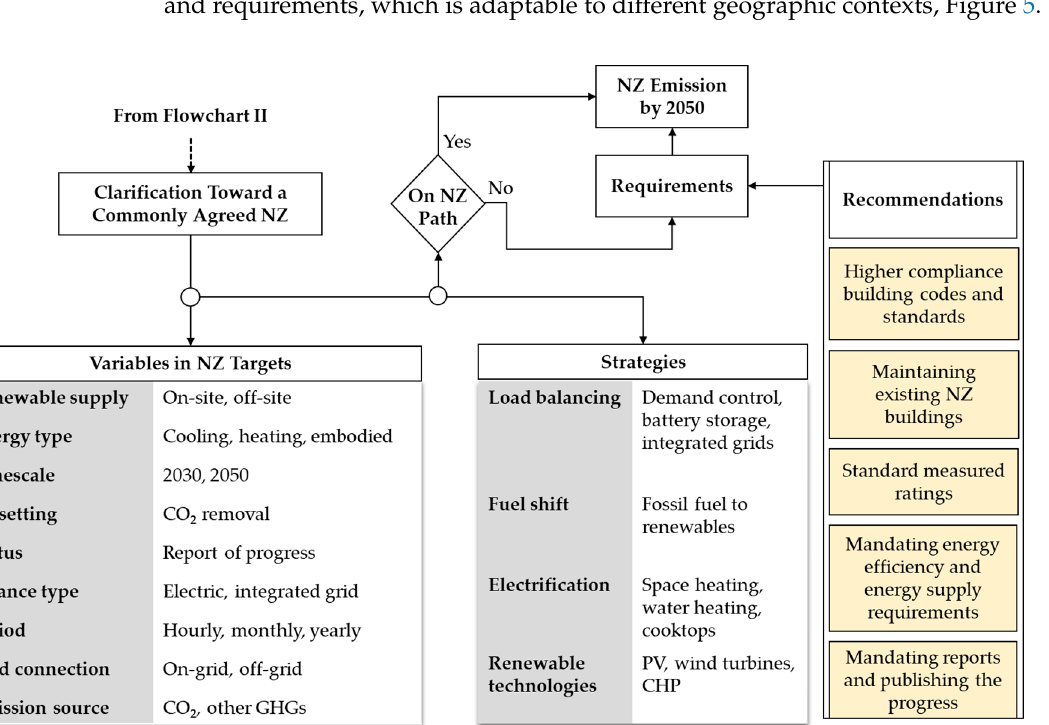
Figure 5. Flowchart III, hierarchical proposed Process for Clarification to Accelerate Net Zero (PC-A-NZ) through variations, strategies, and requirements.